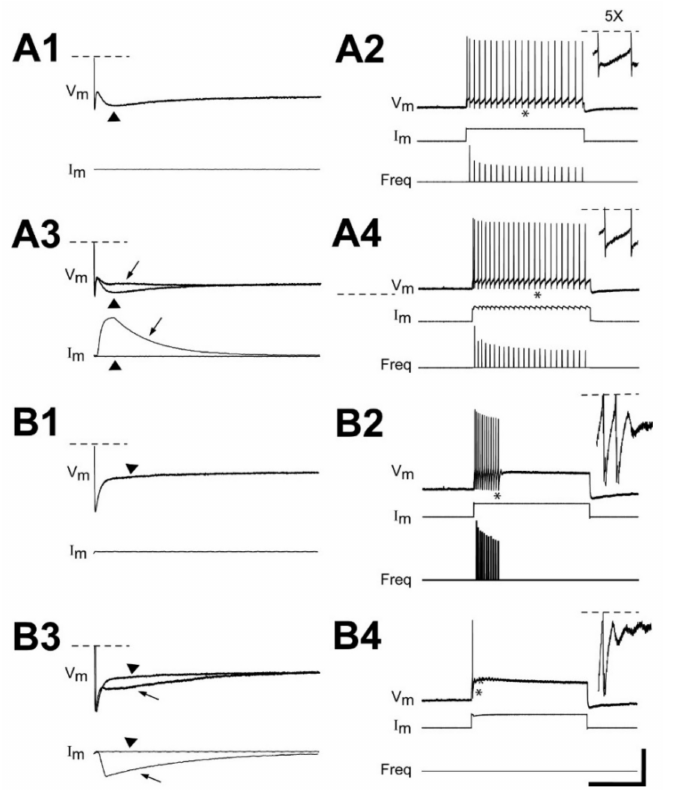
Figure 6. For injured RS neurons, the absence of the sAHP does not induce injury-type firing patterns. Recordings from ( A ) uninjured and ( B ) injured RS neurons in different animals that had recovered for 2 wks following a right spinal cord HT at 10% BL (see Figure 1B). ( A ) Uninjured left “B1” RS neuron (see Figure 1A). ( A1 ) Recording of sAHP (arrowhead) following the repolarizing phase of a single action potential (AP), and ( A2 ) continuous firing in the presence of the sAHP. Membrane potential (V m ), injected current (I m ), and instantaneous firing frequency (Freq). ( A3 ) Afterpotentials before (arrowhead) and after (arrow) electronic removal of the sAHP waveform by current injection (I m , arrow; see Methods) following an AP, and ( A4 ) higher repetitive frequency firing during 2.0 s depolarizing current pulses when the sAHP waveform was removed by current injection after each AP. ( B ) Injured right “M2” RS neuron. ( B1 ) Lack of the sAHP (arrowhead) following a single AP and ( B2 ) firing of a relatively short burst of APs in the absence of the sAHP. ( B3 ) Afterpotentials before (arrowhead) and after (arrow) the addition of an sAHP waveform by current injection fol- lowing a single AP, and ( B4 ) reduced firing when the sAHP waveform was added after each AP. ( A2,A4,B2,B4 ) Insets are expanded (5 × ) sections of recordings at * between or after APs. ( A , B ) Hori- zontal dashed lines indicate truncated APs (for B2 and B4 , fAHPs are truncated). Vertical/horizontal scale bars = ( A1,A3,B1,B3 ) 10 mV, 0.5 nA/100 ms; ( A2,A4,B2,B4 ) 50 mV, 8 nA, 20 Hz/1